Question: Sum up the contents of this chart in one sentence.
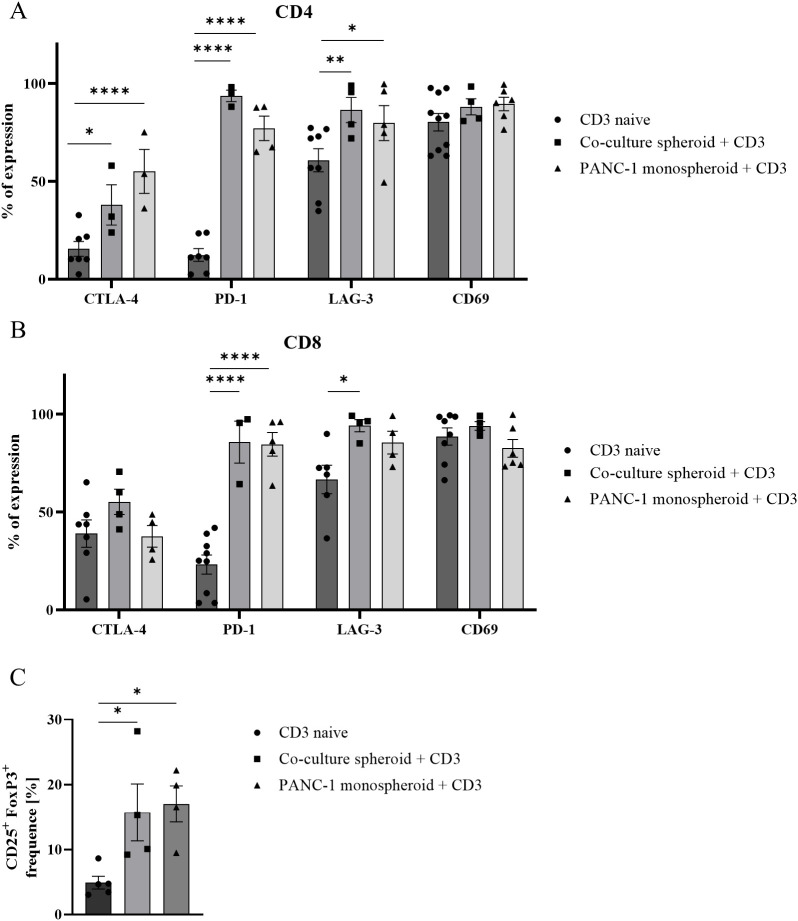
Answer: Checkpoint expression in T-cells after co-cultivation with PANC-1 spheroids. Checkpoint expression in CD4 + (A) and CD8 + (B) T-cells after co-cultivation with PANC-1 spheroids was analyzed by flow cytometry. PANC-1 spheroids were generated prior to infiltration with CD3 + T-cell, isolated from PBMC from healthy donors. T-cells infiltration was performed for 72 h with either co-culture spheroids or PANC-1 monospheroids. T-cells identified as CD3 + and CD45 + were analyzed for surface expression of CTLA-4, PD-1, LAG-3 and CD69. Naïve T-cells isolated from the blood of healthy donors served as control. (C) Frequence of CD25 + FoxP3 + CD4 + T-cells. Frequence of CD25 + FoxP3 + in CD4 + T-cells was analyzed after 72 h of infiltration. Naïve T-cells isolated from the blood of healthy donors served as control. Error bars indicate the standard errors of the mean of at least three independent experiments from three different donors, with *p ≤ 0.05; **p ≤ 0.01; ****p ≤ 0.0001.